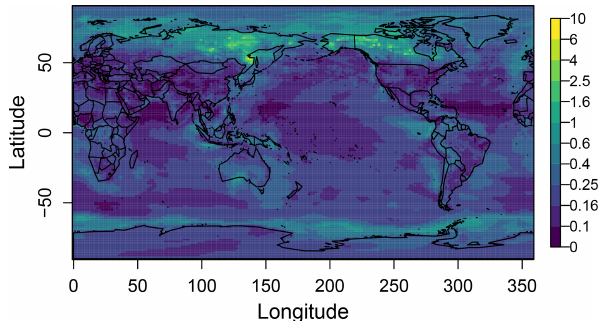
Figure 2. The relative standard deviation for surface-level N 50 con- centration in July, used in the estimation of the interannual variabil- ity component of representativeness error R iav